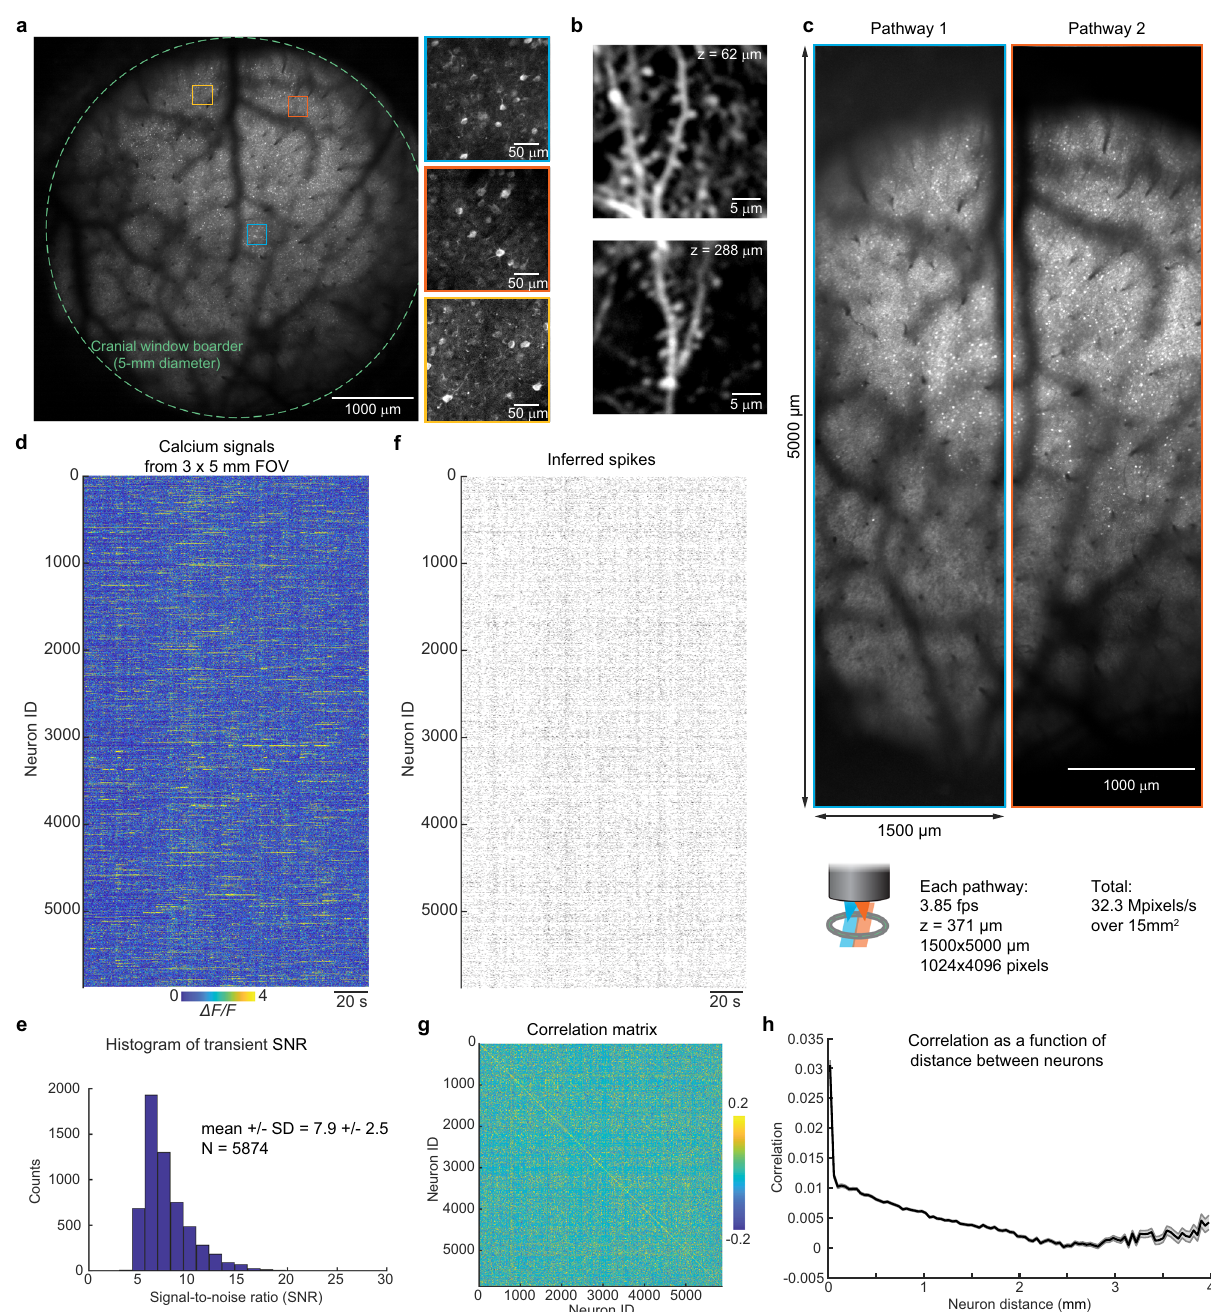
Fig. 2 Diesel2p provides subcellular resolution two-photon imaging of neural activity across its FOV. a Diesel2p ’ s galvo-galvo raster scanning records neuronal activity at the depth of 345 µ m through a cranial window with a diameter of 5 mm (dashed line) on a transgenic mouse expressing the genetically encoded fl uorescent calcium indicator GCaMP6s in excitatory neurons. Three zoom-in views from different sub-regions (colored squares) show the preservation of the subcellular resolution. b Dendritic spines were resolved in vivo from a transgenic mouse expressing Thy1-GFP at different depths. c Neuronal activity in two strips of cortex are recorded using Diesel2p ’ s two pathways simultaneously (blue and orange rectangles), covering a combined area of 3 mm × 5 mm with a frame rate of 3.85 frames/s. The imaging depth is 371 µ m. The pixel number for each image is 1024 × 4096 pixels. d In this data set, calcium signals were recorded from 5,874 active neurons. e The histogram of the transients ’ signal-to-noise ratio in d . f Ca 2 + signals in d were used to infer spike times. g Spikes in f were used to measure >17 million cross-correlations per experiment. h The correlations in g plotted as a function of distance between neurons ranging from 0 μ m to 4000 μ m. Data are presented as mean values ±